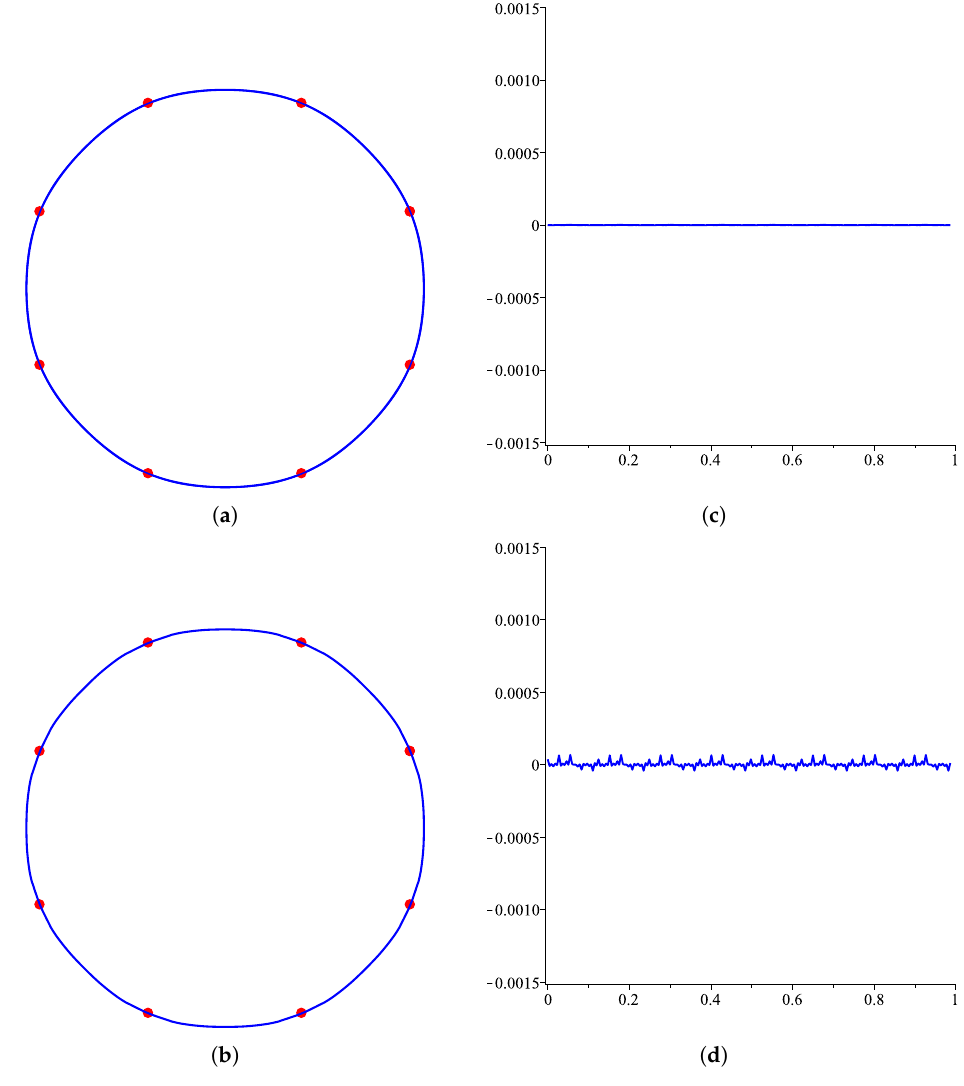
Figure 1. Results for various choices of the parameter u are shown on the left together with their corresponding curvature on the right. From top to bottom: u = 0 and 0.0074. ( a ) Limit curve at u = 0; ( b ) Limit curve at u = 0.0074; ( c ) Curvature plot of (a); ( d ) Curvature plot of ( b